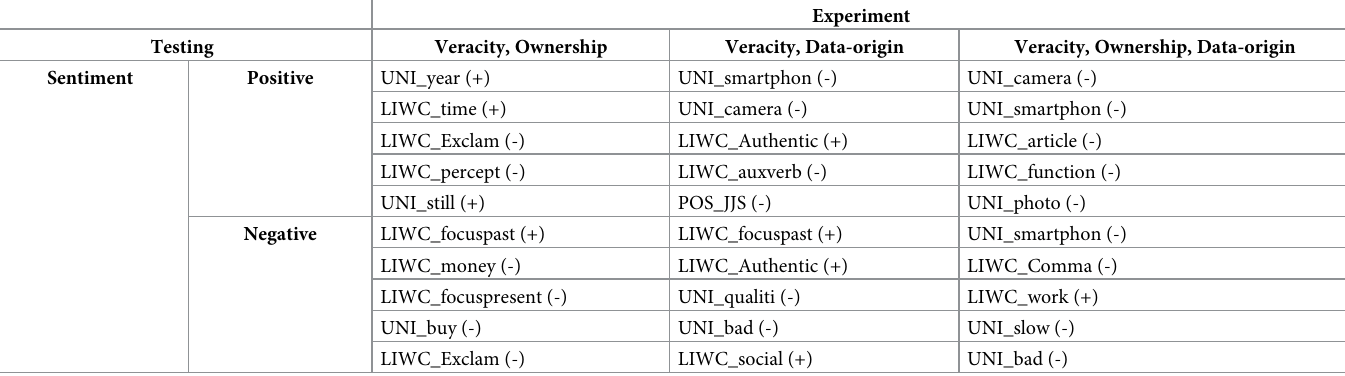
Table 4. Top 5 feature differences by Bayes Factor 10 for all confounded classifications; BF 10 > 188 for each feature; (+) = feature appears more often in truthful reviews; (-) = feature appears more often in deceptive reviews; see S6 Table for all feature